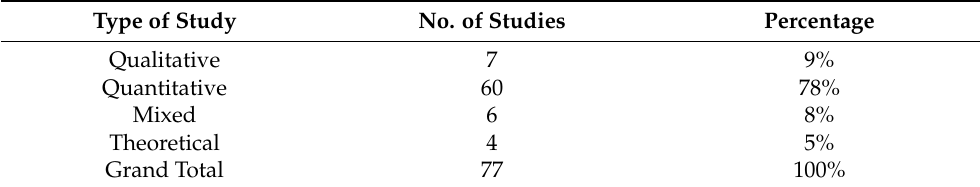
Table 8. Type of